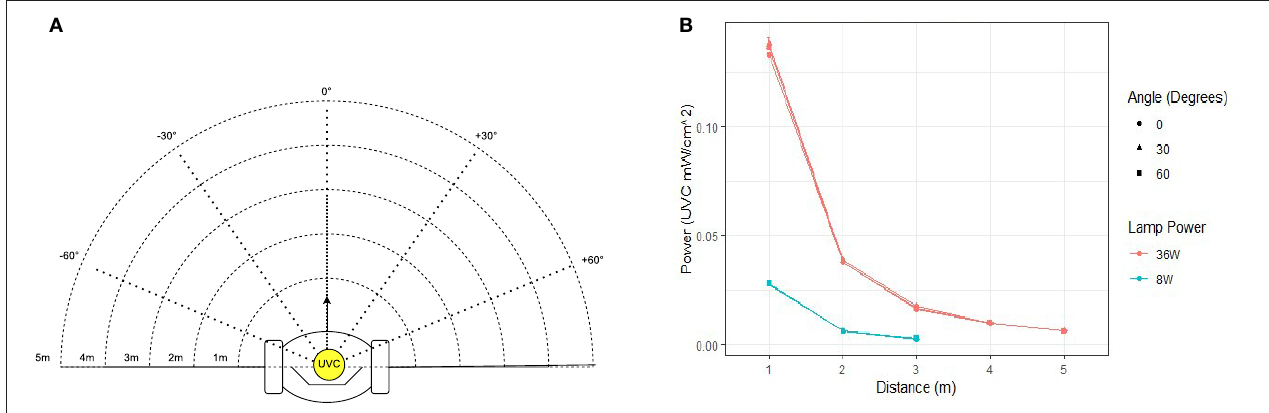
FIGURE 2 | Measured UV-C field in the region around the robot. (A) Measurements were taken at distances of 1–5 m at intervals of 30. (B) Graph illustrating the UV-C output of the 8 and 36 W lamp used in this study.